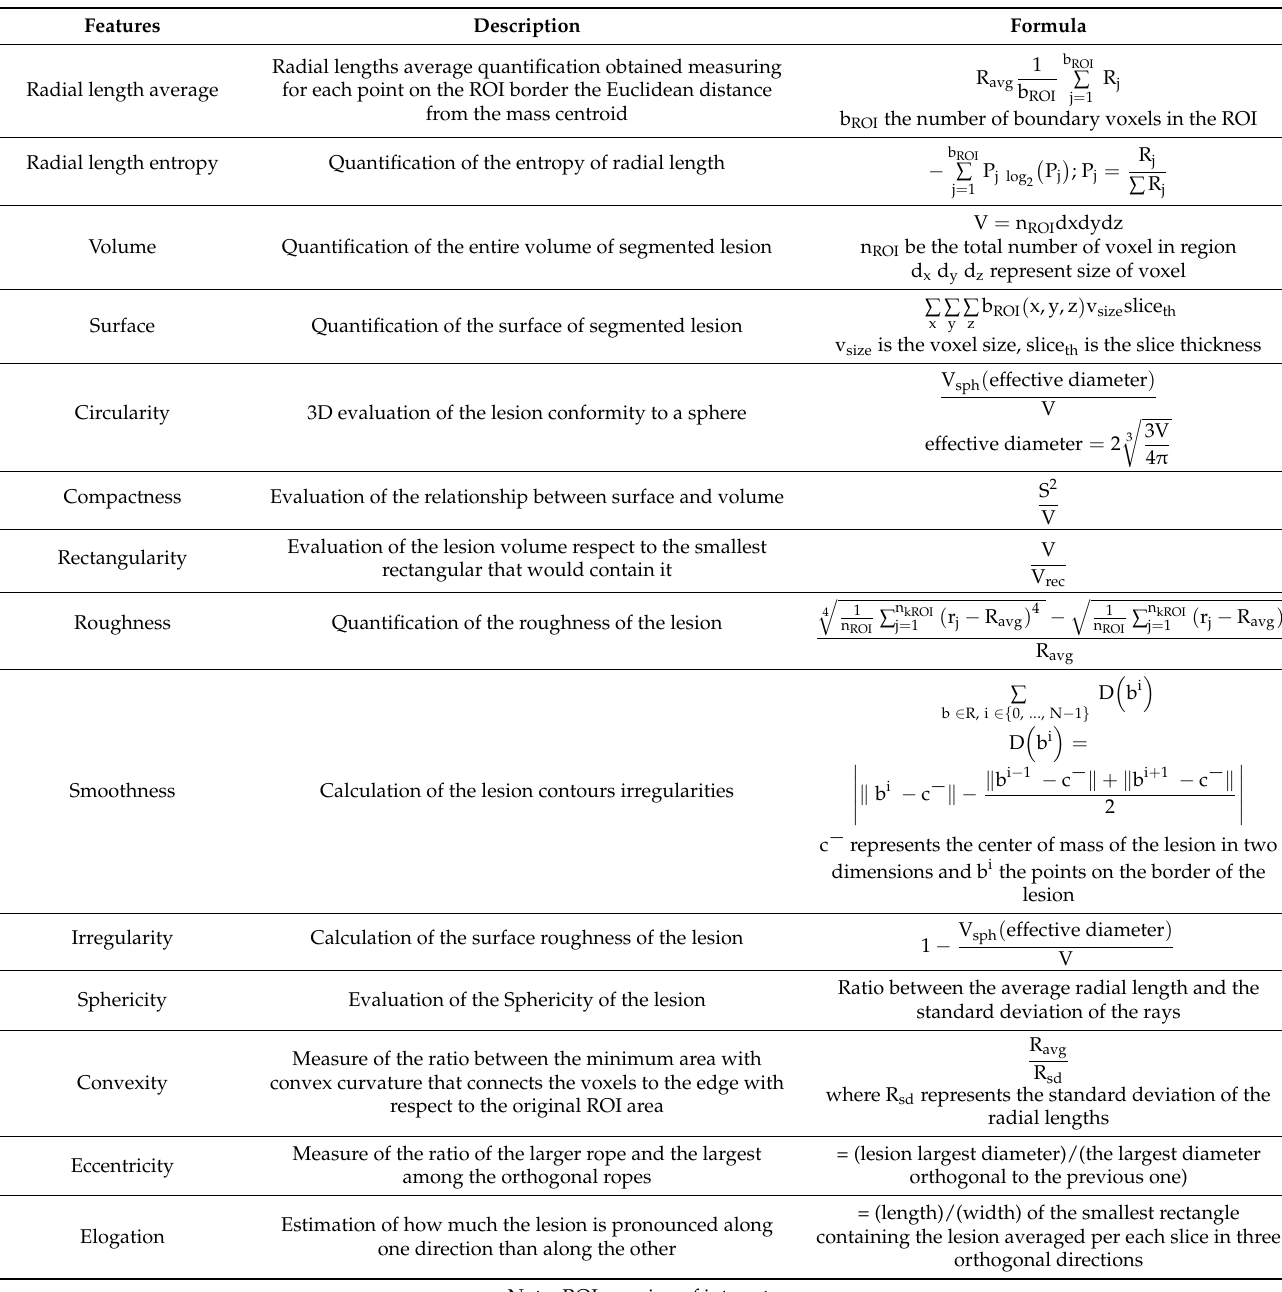
Table 3. Morphological parameters description and